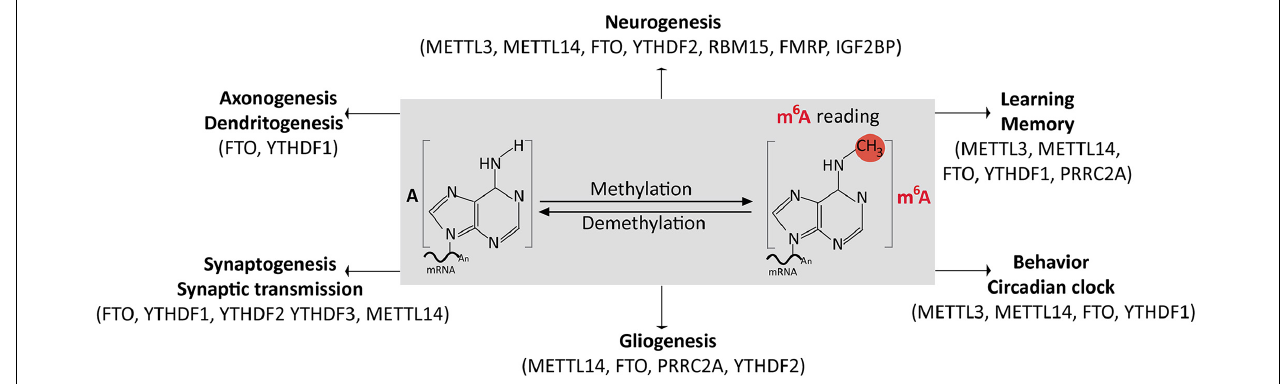
FIGURE 3 | An illustration summarizing the role of N 6 -methyladenosine (m 6 A) in brain development and function. The functions of the various m 6 A-related factors involved in the proliferation and differentiation of neural precursors, neuronal maturation, production of glia, synapse formation during brain development, and common brain physiology are